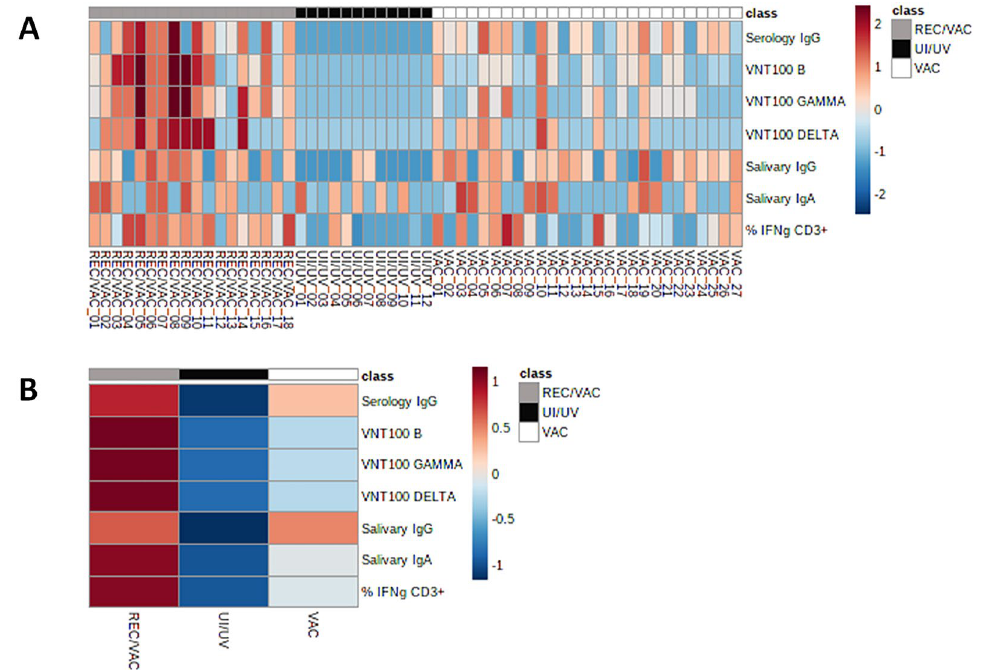
Figure 5. Integrated data representation of analysed samples. ( A ) Hierarchical clustering heat maps without a reorganization of samples and features based on the values regarding the serology IgG, Virus Neutralization Titre (VNT 100 ) B, VNT 100 Gamma, VNT 100 Delta, salivary IgG, salivary IgA and %IFNg CD3+ for a total of 57 individuals: 27 in the VAC group (COVID-19 vaccinated), 18 in the REC/VAC group (COVID-19 recovered vaccinated individuals), and 12 in the UI/UV group (negative control)). ( A ) The values are shown as rectangles containing different colours corresponding to the levels indicated by the scale bar on the right. Each column represents each individual, and each line represents each variable (aerology IgG, VNT 100 B, VNT 100 Gamma, VNT 100 Delta, salivary IgG, salivary IgA and %IFNγ CD3+). The colours on the top represent each block of the three different groups (VAC—grey, REC/VAC—black and UI/UV—white). ( B ) Heat map based on the group averages. The average values are shown as rectangles containing different colours corresponding to the levels indicated by the scale bar on the right. Each line represents each variable (serology IgG, VNT 100 B, VNT 100 Gamma, VNT 100 Delta, salivary IgG, salivary IgA and %IFNγ CD3+), and each column represents each group. The colours on the top represent each block of the three different groups (VAC—grey, REC/VAC—black and UI/ UV—white). The variables were normalized to a 0–100 scale by subtracting the minimum and dividing by the maximum of all the observations. The minimum and maximum values observed here were considered for each variable; a = 0 and b = 100. Second, all the normalized data were log-transformed (base 10). Then, the data were submitted to the Metaboanalyst 5.0